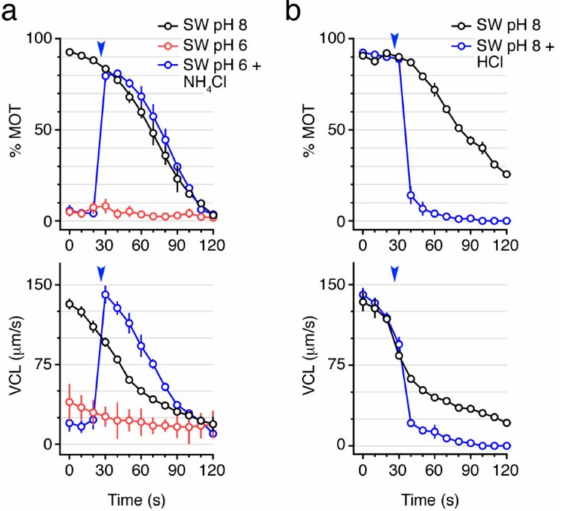
Figure 2. A basic pH is necessary to activate and maintain motility of seabream spermatozoa. ( a ) Time- course of total motile sperm (% MOT) and curvilinear velocity (VCL) upon activation in seawater (SW) at pH 6 or 8. Sperm activated at pH 6 was exposed to 250 mM NH 4 Cl at 25 s after activation (arrowhead). ( b ) % MOT and VCL of spermatozoa activated in SW at constant pH 8, or exposed to 1.6 mM HCl at 25 s after activation (arrowheads). Data are the mean ± SEM ( n = 3–4 males, one ejaculate per